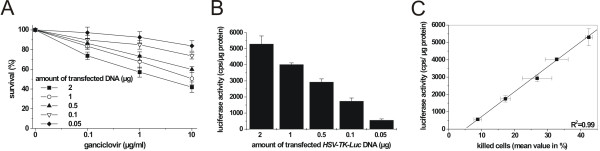
Cytotoxic and bioluminescent activity in U87MG glioma cells transiently transfected with different amounts of HSV-TK-Luc plasmid. (A) Cytotoxic activity as measured by MTT assay and (B) luciferase activity as determined luminometrically in cell lysates. Results are displayed as counts per second (cps)/ μg protein. (C) Linear regression analysis of cytotoxic activity plotted against luciferase activity for the different amounts of plasmid DNA. Results from 3 independent experiments were used.